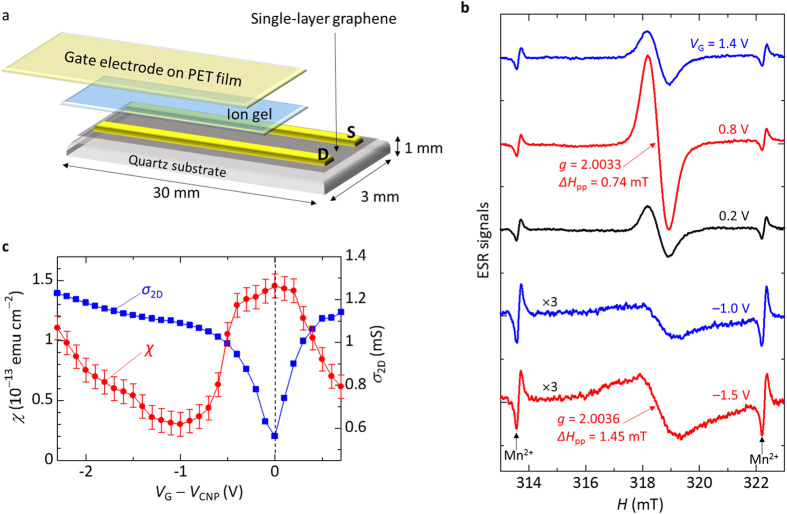
Schematics of a graphene transistor and the ESR and device characteristics.(a) Schematic of the device structure of a graphene transistor used in this study. (b) ESR spectra of the graphene transistor at positive and negative VG, where VD = 0.1 V at the external magnetic field H perpendicular to the substrate (H⊥) at 300 K. (c) Dependence of the spin susceptibility, χ, and the sheet conductivity, σ2D, of the graphene transistor on VG − VCNP, where VD = 0.1 V at H⊥ at 300 K. The VCNP is defined as the VG at a charge neutral point in the graphene transistor.